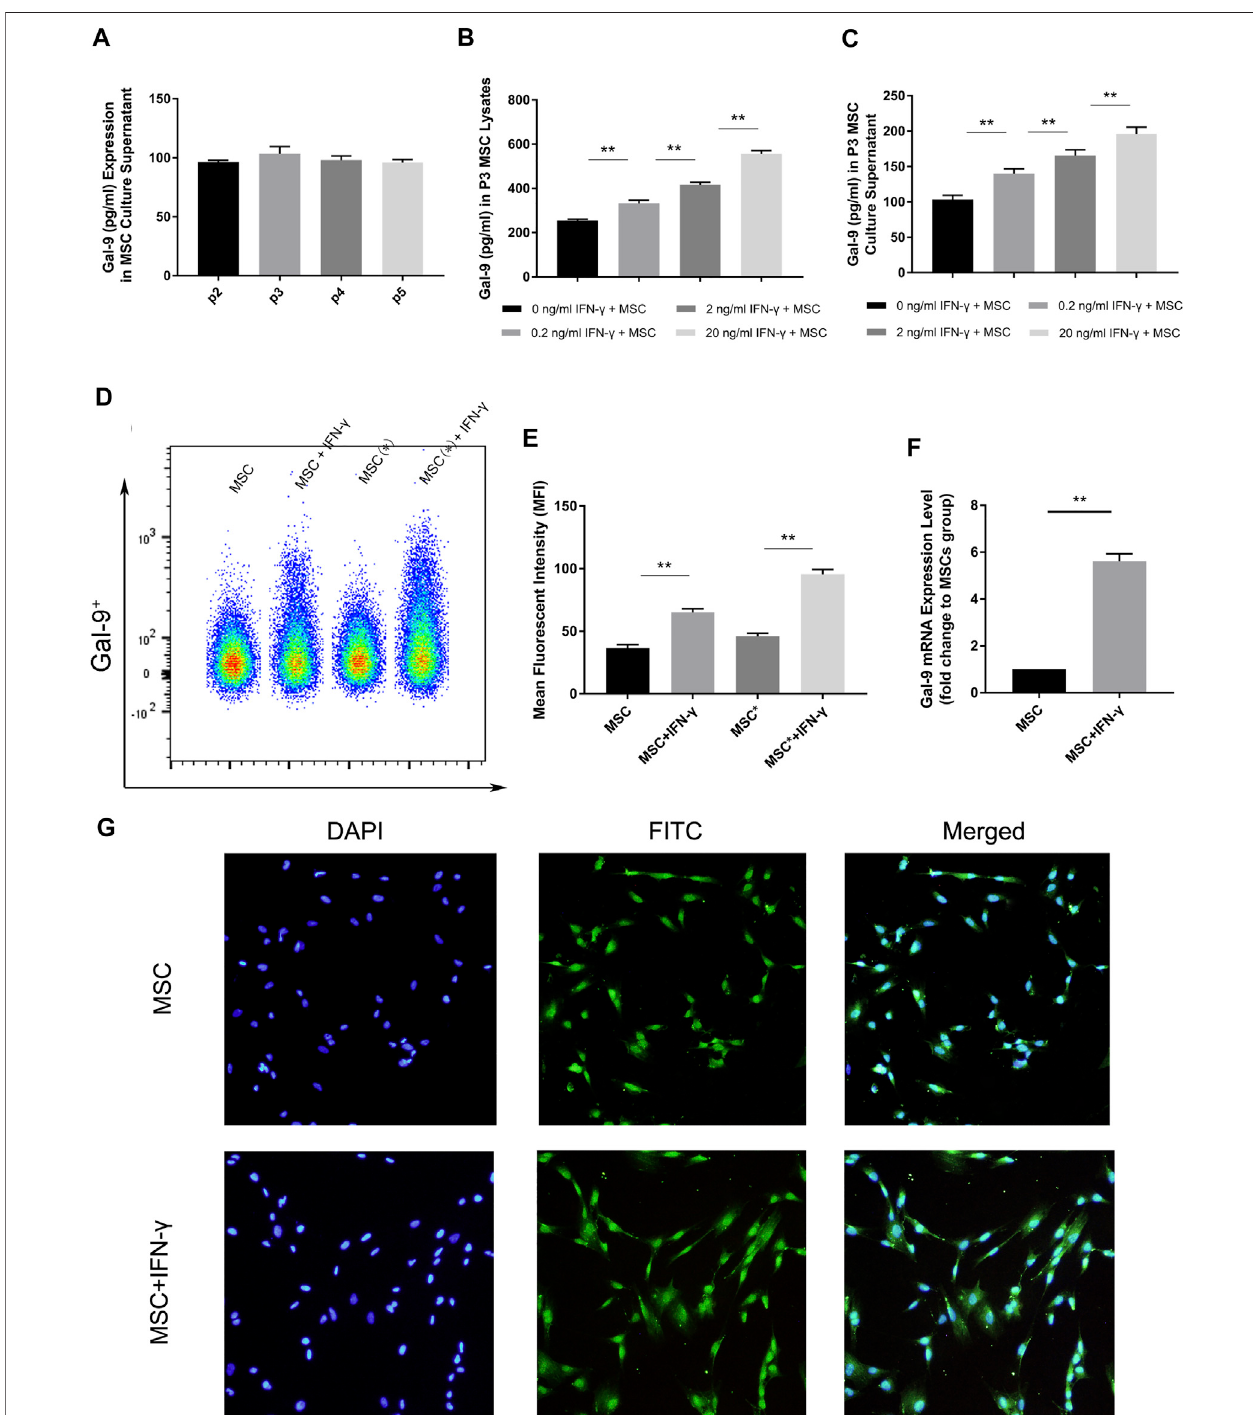
FIGURE1| IFN- γ stimulationcouldenhanceGal-9expressioninAD-MSCs. (A) Gal-9expressioninsecondto fi fthgenerationMSCsupernatant. n =3. (B – C) Gal-9 expression in third generation MSC lysate and culture supernatant increased in a dose-dependent manner by IFN- γ stimulation. n = 3. * p < 0.05, ** p < 0.01. (D – E) Fluorescence intensity of Gal-9 in different samples (* indicates: permeabilization and fi xation optimized before fl uorescent antibody staining). (F) Gal-9 mRNA relative expression in IFN- γ pre-stimulated MSCs (20 ng/ml IFN- γ , 72 h) and non-stimulated MSCs. n = 3. * p < 0.05, ** p < 0.01. (G) Representative immuno fl uorescence fi gures of MSCs with IFN- γ pre-stimulation (20 ng/ml, 72 h) or not. The nucleus was presented as blue and Gal-9 protein appeared as green. Bar graphs represent mean ± SD. Abbreviation: Gal-9, Galectin-9; p2-p5, passage 2-passage 5; MSC, mesenchymal stem cell.